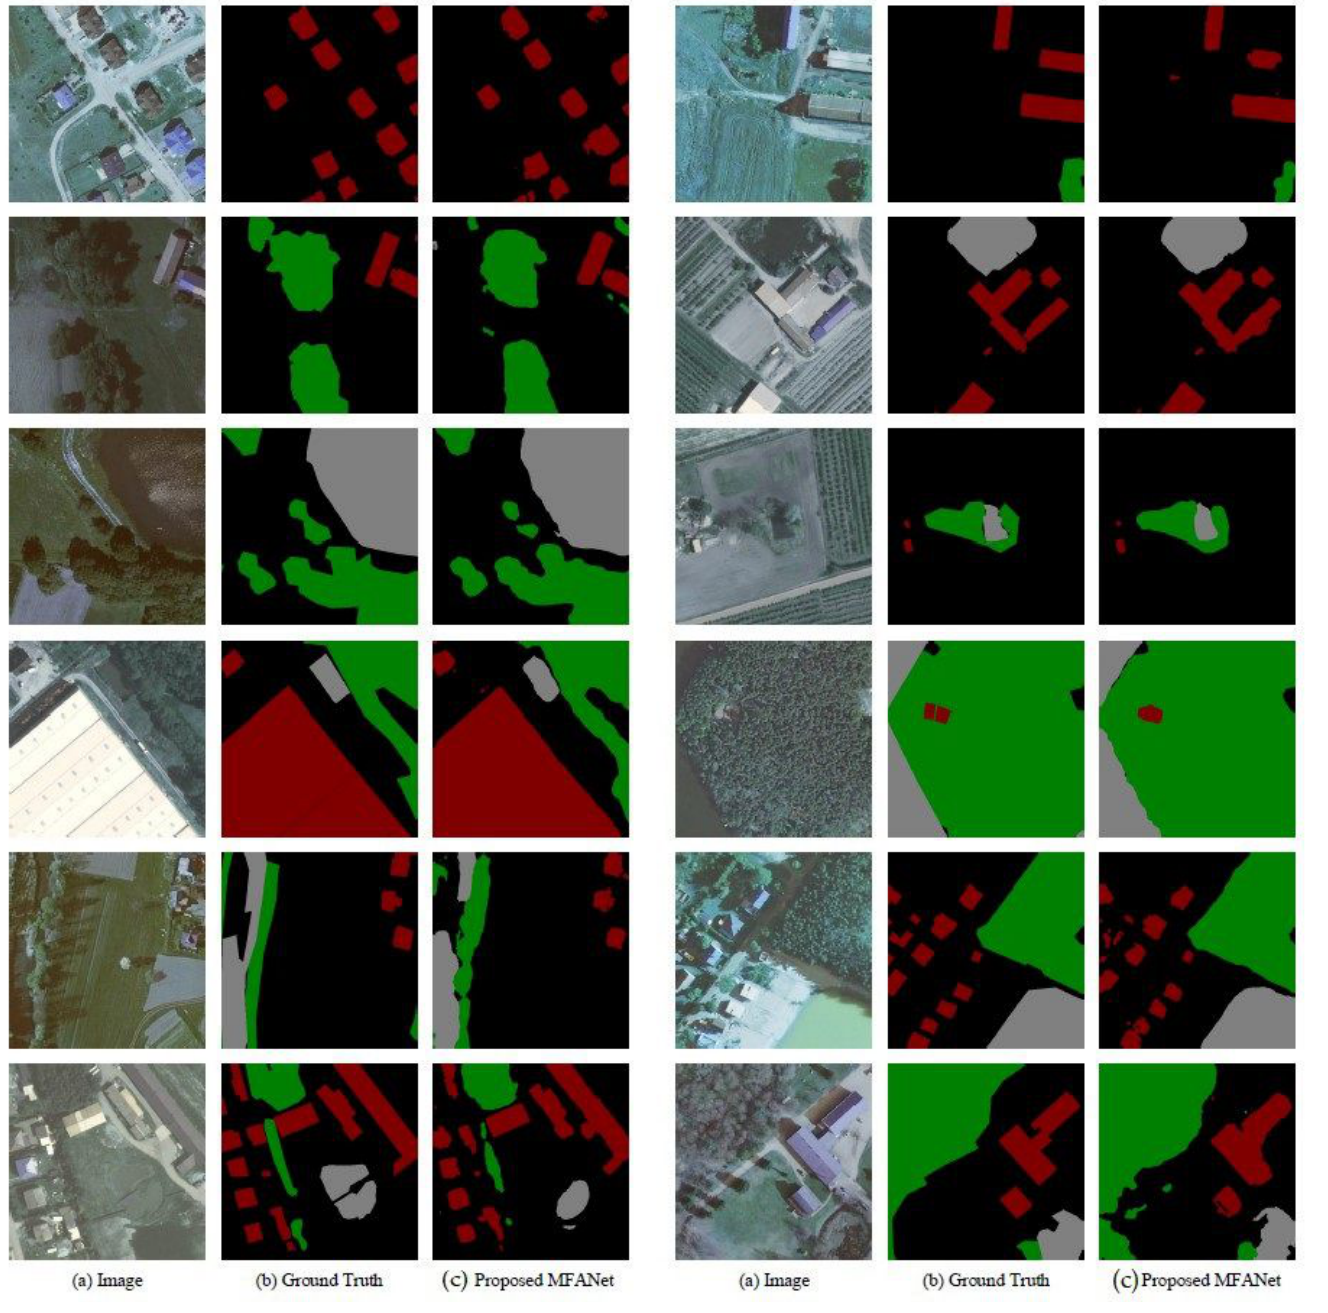
Figure 9. Results of MFANet on LandCover testing set. ( a ) The original images; ( b ) Corresponding labels; ( c ) The predicted maps of proposed